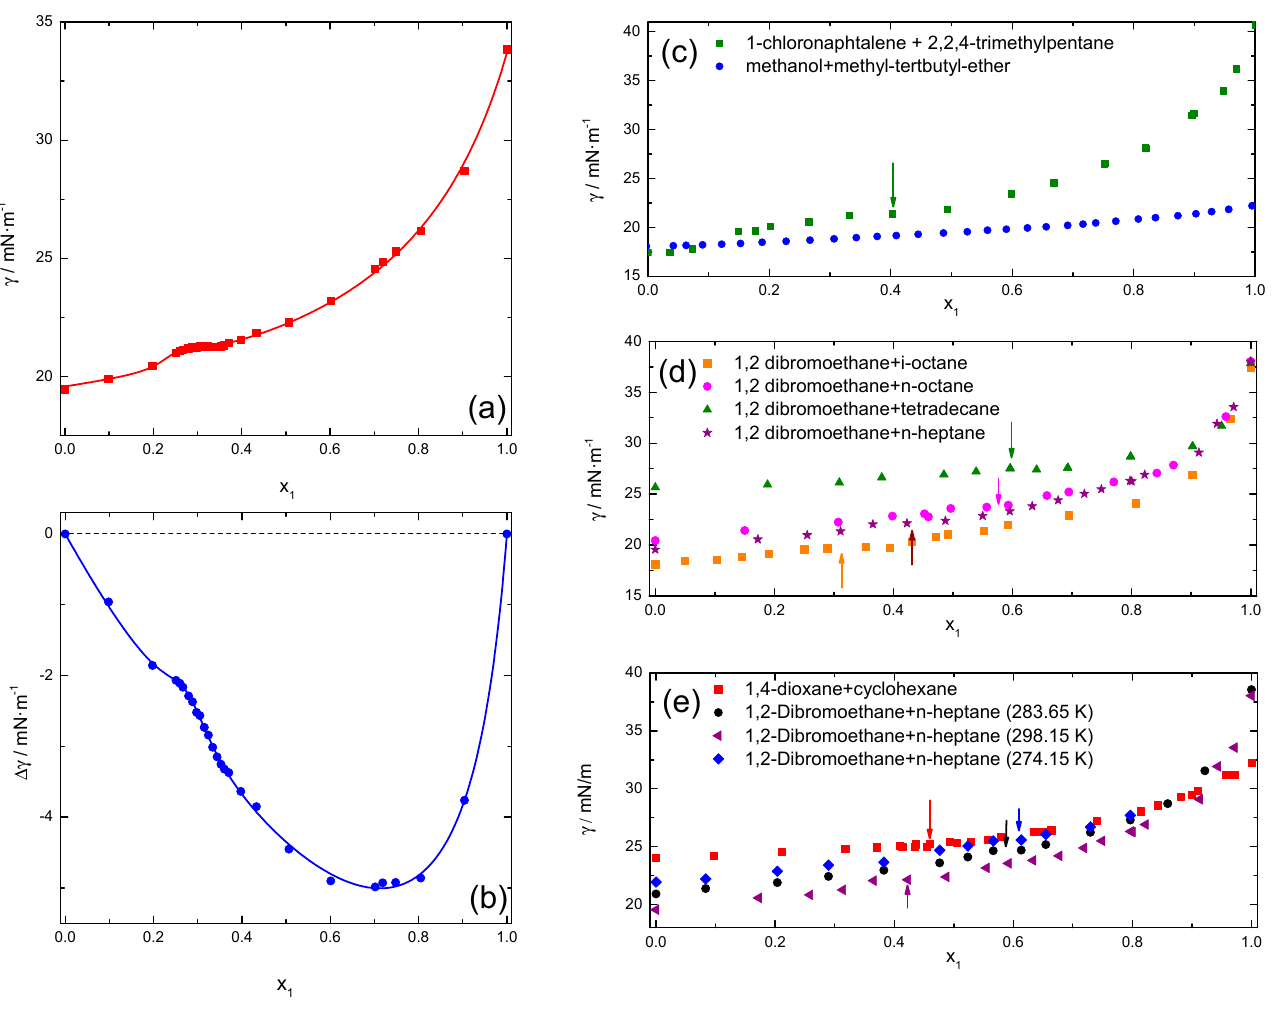
Figure 1. Composition of dependences of the surface tension ( a ) and mixing surface tension, ∆ γ , ( b ) at 298.15 K for 1,4-dichlorobutane + n-heptane mixtures. Symbols are the experimental results and curves that fit into Equation (4) with n = m = 3. In panels from ( c – e ), the composition dependences of the surface tension for the different studied systems are displayed. The insets identify the mixtures and the temperatures of the measurements, 298.15 K, unless the other value is specified. The arrows indicate the positions of the pseudo plateaus.